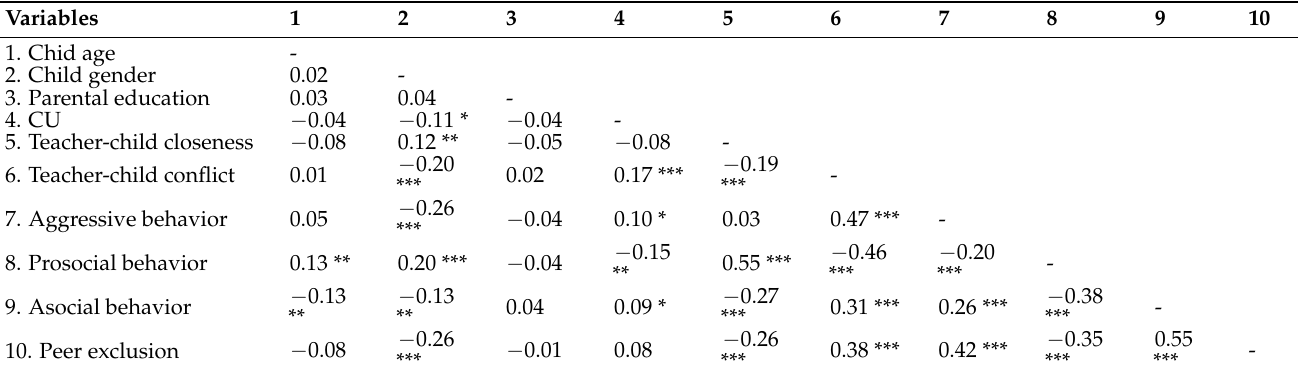
Table 1. Means, standard deviations, and correlation coefficients for the study